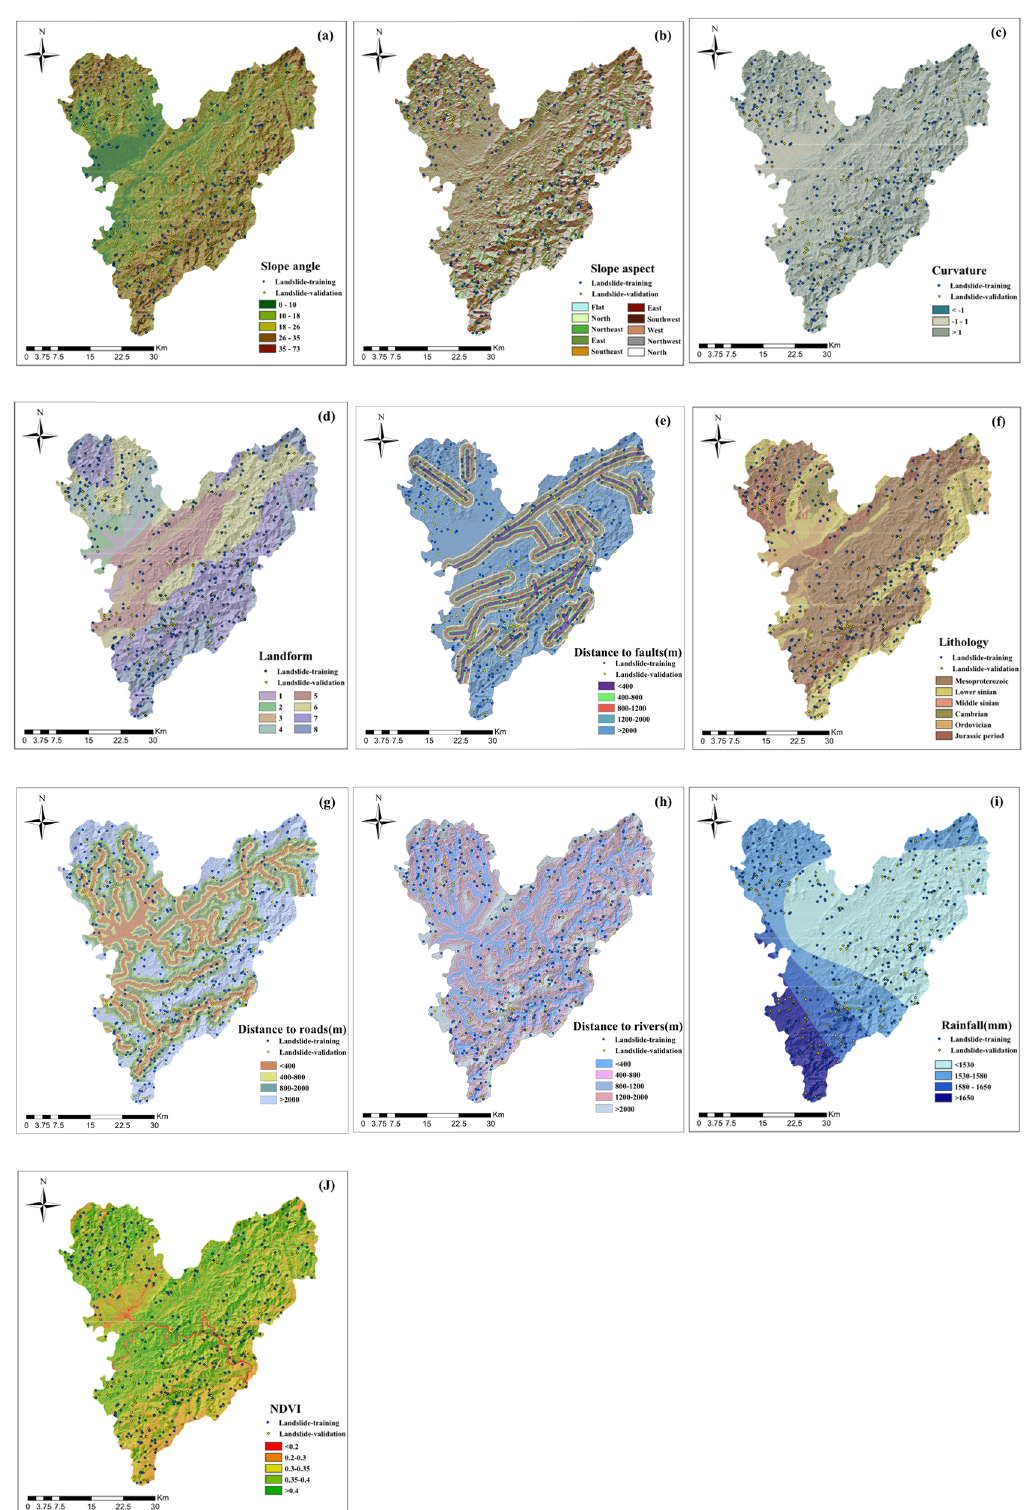
Figure 3: Landslide in fl uencing factor maps: ( a ) slope angle; ( b ) slope aspect; ( c ) curvature; ( d ) landform; ( e ) distance to faults; ( f ) lithology; ( g ) distance to roads; ( h ) distance to rivers; ( i ) rainfall, and ( j )